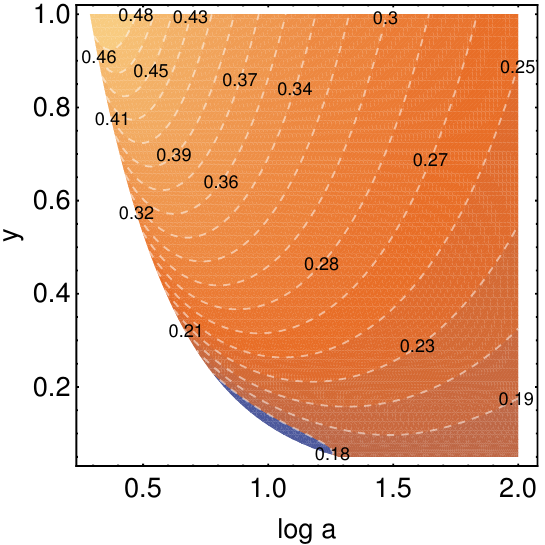
Figure 7 . Graviton-graviton scattering: the relative difference r = | Λ 2 function of log a ( x axis) and y ( y axis). We restrict our analysis to the values 0 . 05 ≤ y ≤ 1 and log a ≤ 2